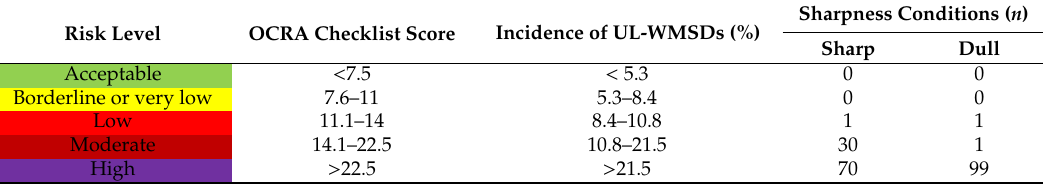
Table 6. Risk assessment of repetitive upper limb movements in sharpness